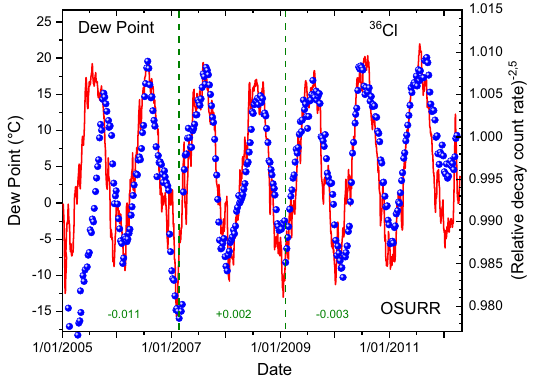
Figure 10. Local shift and power of − 2.5 applied to relative deviations on measured decay rates of 36 Cl at OSURR (dots), compared to dew point data from a nearby weather station